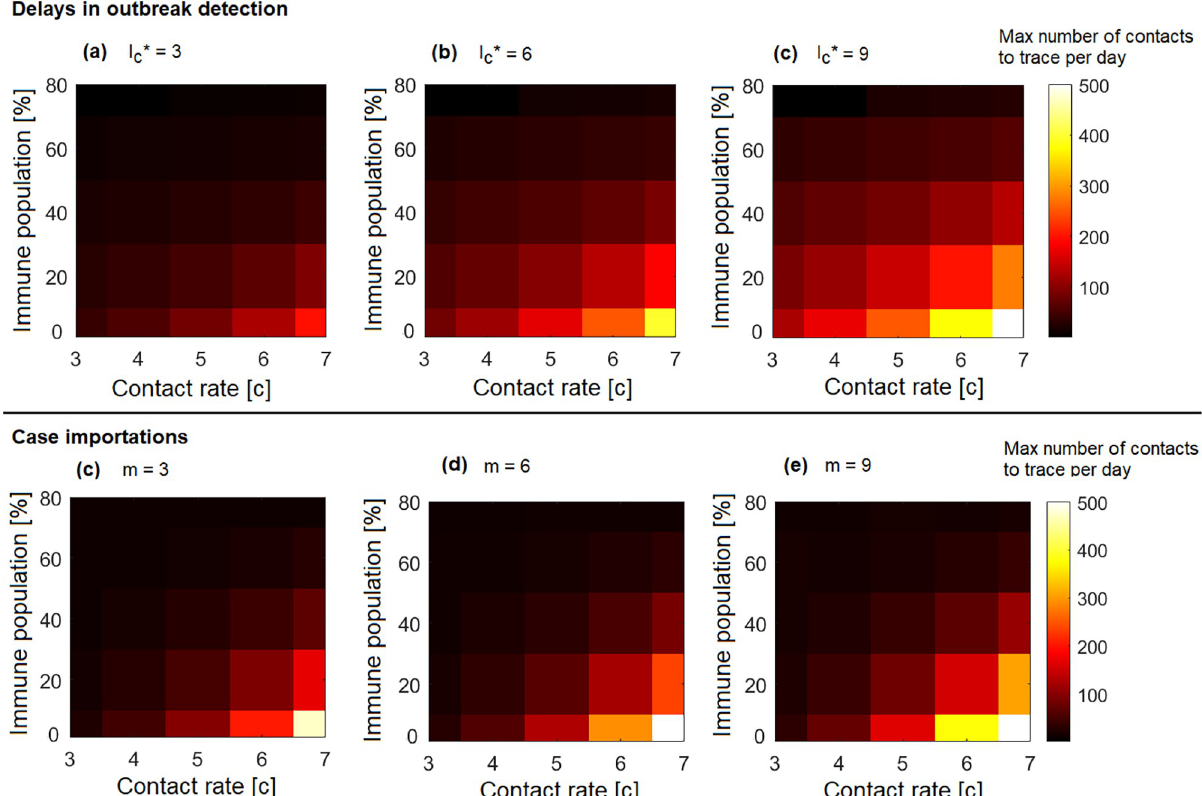
Fig 3. Maximal number of contacts to trace per day as a function of the proportion of immune individuals in the population and the contact rate. The number of symptomatic individuals already present in the community when contact tracing is activated ( I � ¼ 3 , to (b) I � ¼ 6 , to (c) I � ¼ 9 . In figures (d)-(f) I � ¼ 3 for all simulations, and the number of imported cases m over the time interval considered I � c c c c (i.e., T = 180 days) varies, with (d) m = 3, (e) m = 6, and (f) m = 9. The contact tracing efficiency is kept constant at q = 0.75.